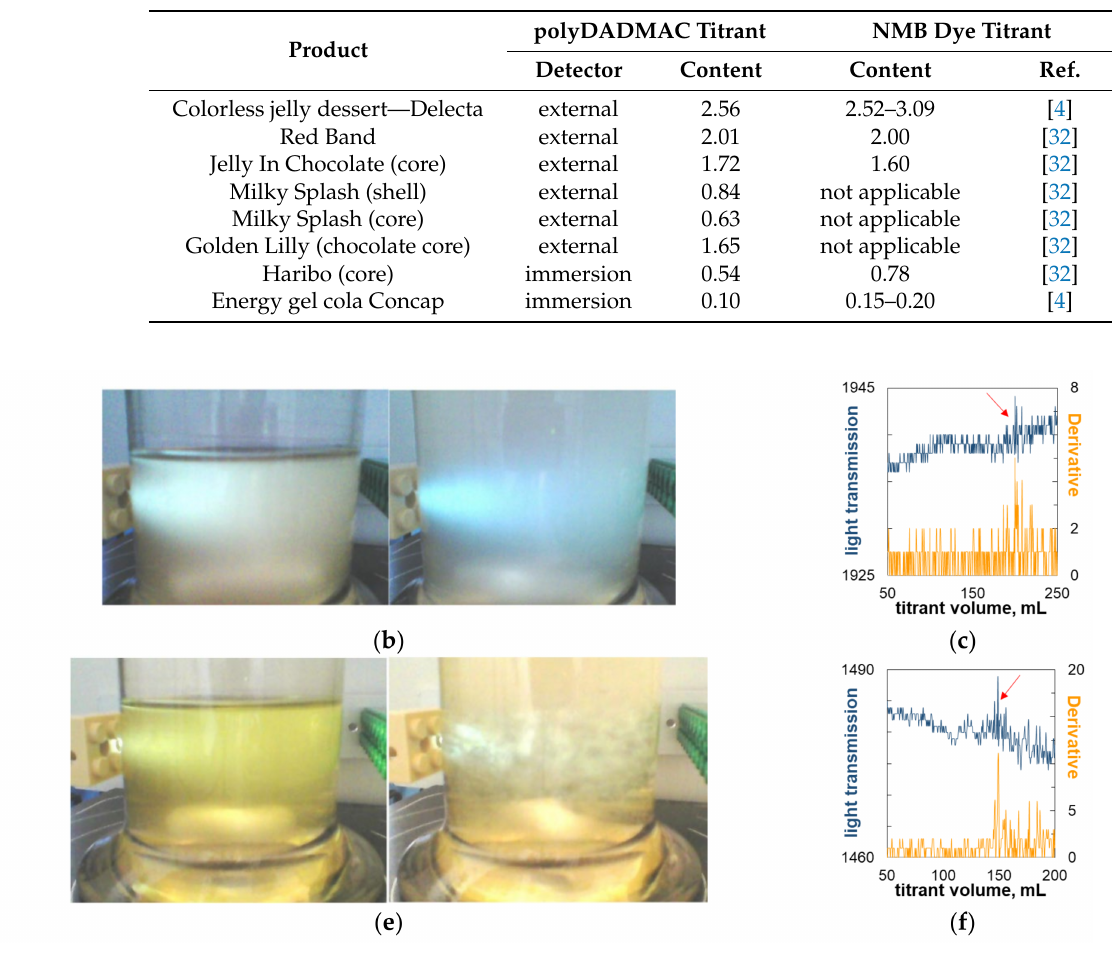
Figure 9. Illustration of the determination of carrageenan in commercial samples. ( a ) Red Band and ( d ) Jelly In Chocolate (the analyzed part of the product is indicated by an arrow), using external sensor; ( b , e ) analyte solution before titration ( left ) and at the endpoint ( right ); ( c , f ) titration curves (the color of the line corresponds to the color of the description of the vertical axis; the arrow indicates the endpoint of the